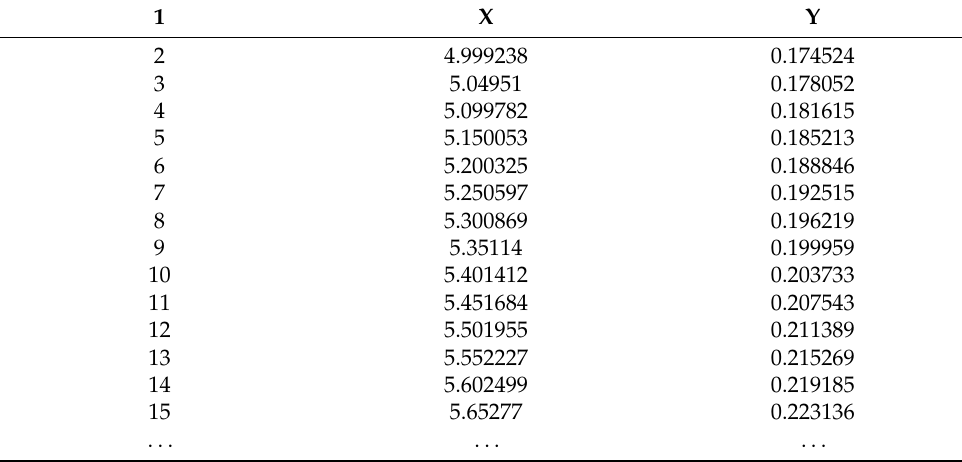
Table 5. X and Y coordinates of the car saved in an Excel file.